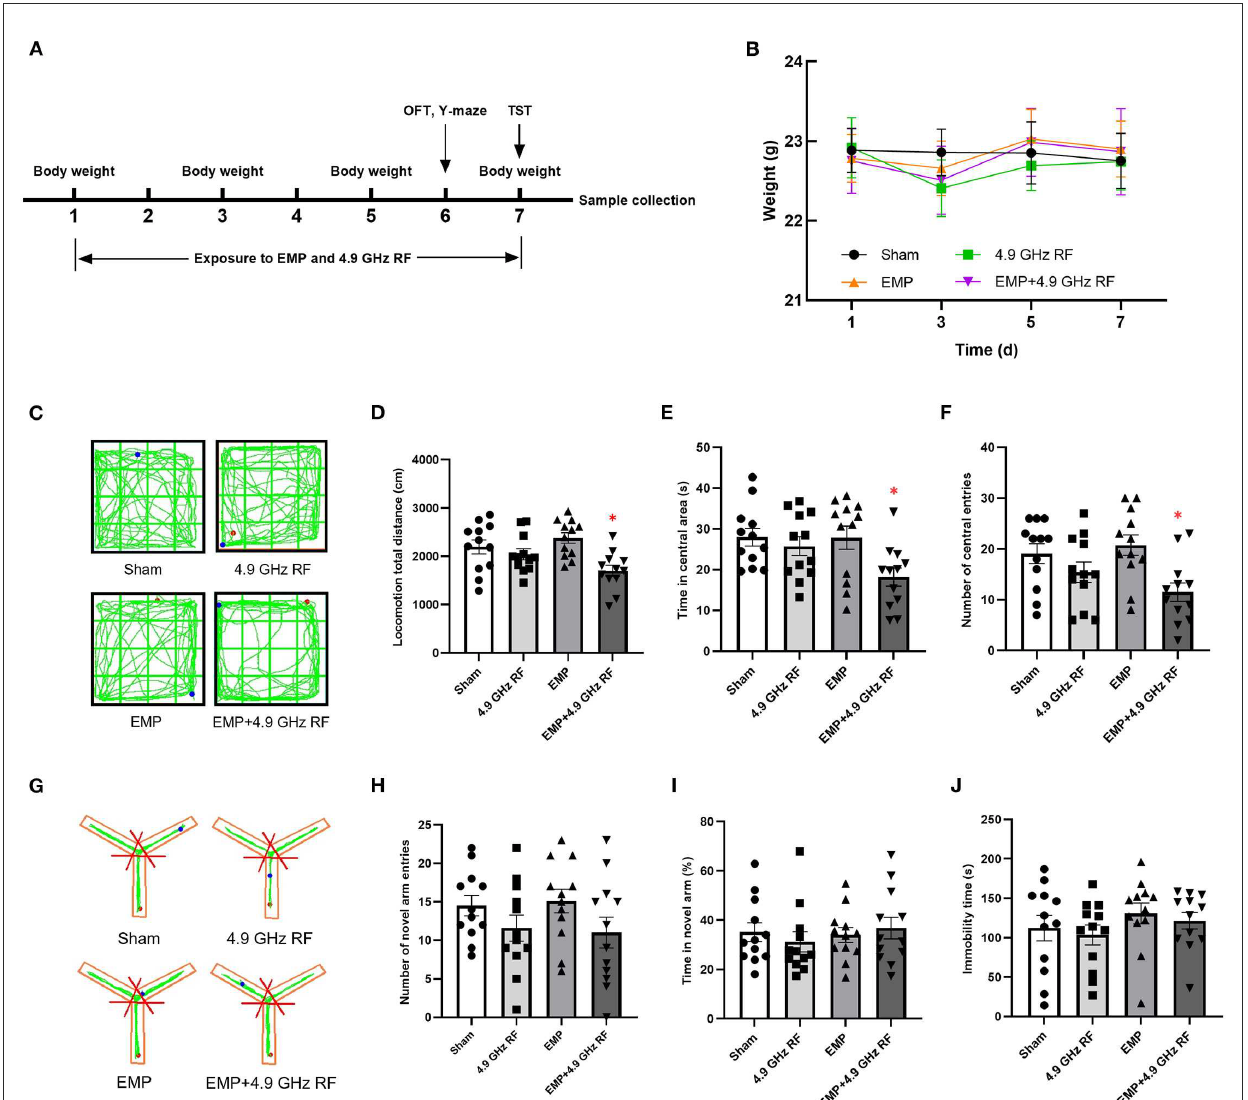
FIGURE2 Effects of combined exposure to EMP and 4.9 GHz RF on general health and ethology. (A) Time schedule of exposure for mice. (B) Body weight of mice. n = 12 for each group. (C) The representative original trace of OFT. (D) Locomotion total distance in open field. (E) Time spent in central area. (F) Number of central entries. (G) The representative original trace of Y-maze. (H) Number of novel arm entries. (I) Percentage of time spent in novel arm. (J) Immobility time. * P < 0.05 vs. Sham group. n = 12 for each